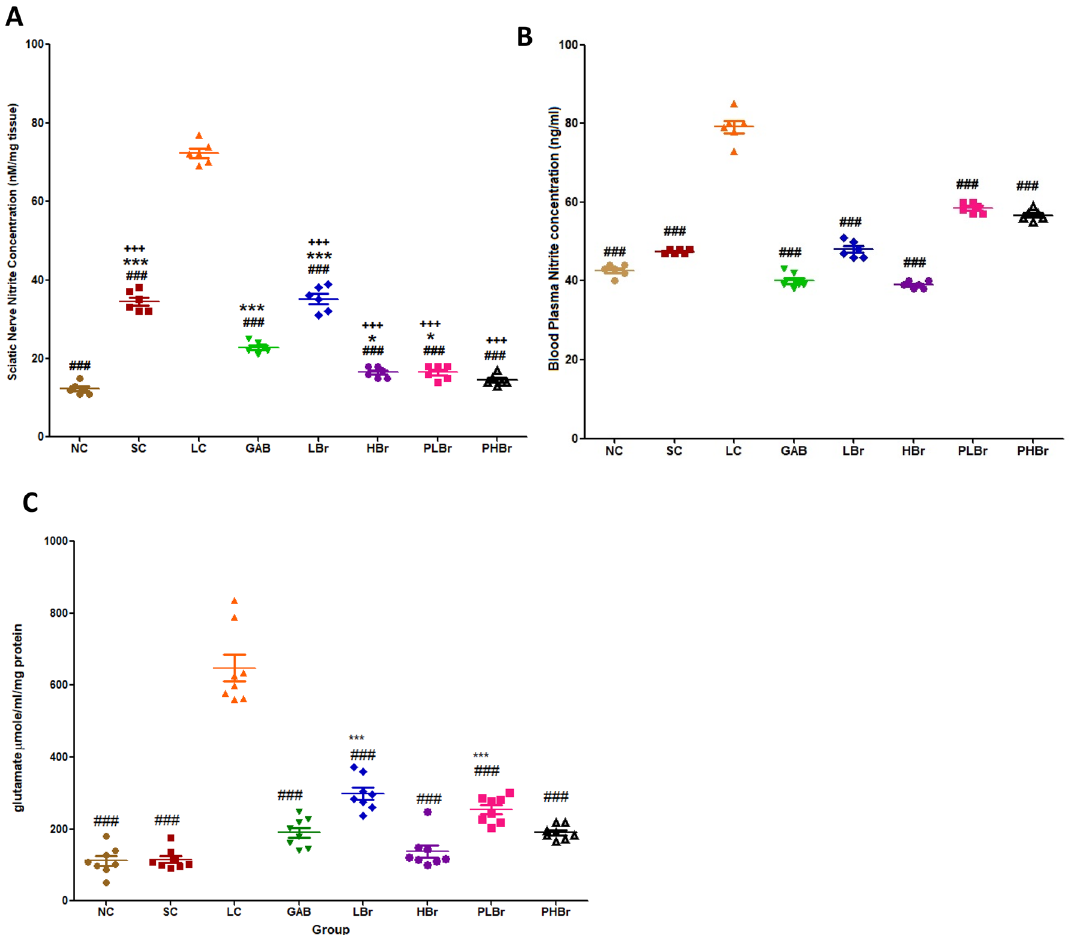
Figure 8. Bromelain reduced nitrate and glutamate concentration in the chronic constriction injury model of neuropathic pain. Each values represent mean ± SEM of each group (n = 8). ( A ) Nitrate level in sciatic nerve ( B ) nitrate level in the blood plasma ( C ) glutamate concentration in the sciatic nerve. # p < 0.05, ## p < 0.01, ### p < 0.001 compared with ligated control; *p < 0.05, **p < 0.01, ***p < 0.001 compared with normal control; + p < 0.05, ++ p < 0.01, +++ p < 0.001 compared with reference control. NC Unligated Normal Control, SC Sham Control, LC Ligated Control, GAB Gabapentin Reference Control (30 mg/kg gabapentin), LBr Low Dose Bromelain (30 mg/ kg), HBr High Dose Bromelain (50 mg/kg), PLBr Pre-treated Low Dose Bromelain (30 mg/kg), PHBr Pre- treated High Dose Bromelain (50